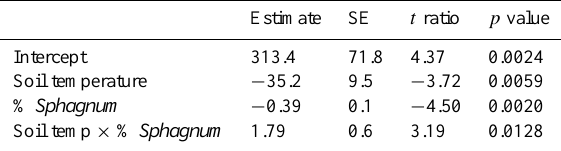
Table 5. Multiple regression model of CH 4 :CO 2 explained by per- cent cover of Sphagnum and soil temperature. ( R 2 = 0 . 82, F 3 , 11 = 11 . 9, p = 0 . 002). Slope estimates and standard errors (SE) are re- ported along with t ratio and associated p value. Estimate SE t ratio p value